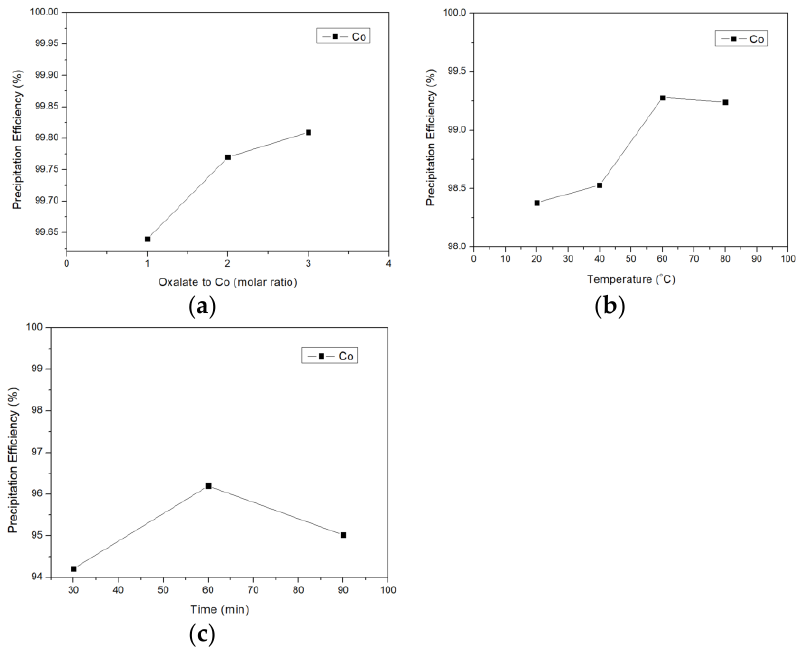
Figure 6. Effects of ( a ) oxalate to Co molar ratio, ( b ) temperature, and ( c ) time on the Co precipitation.